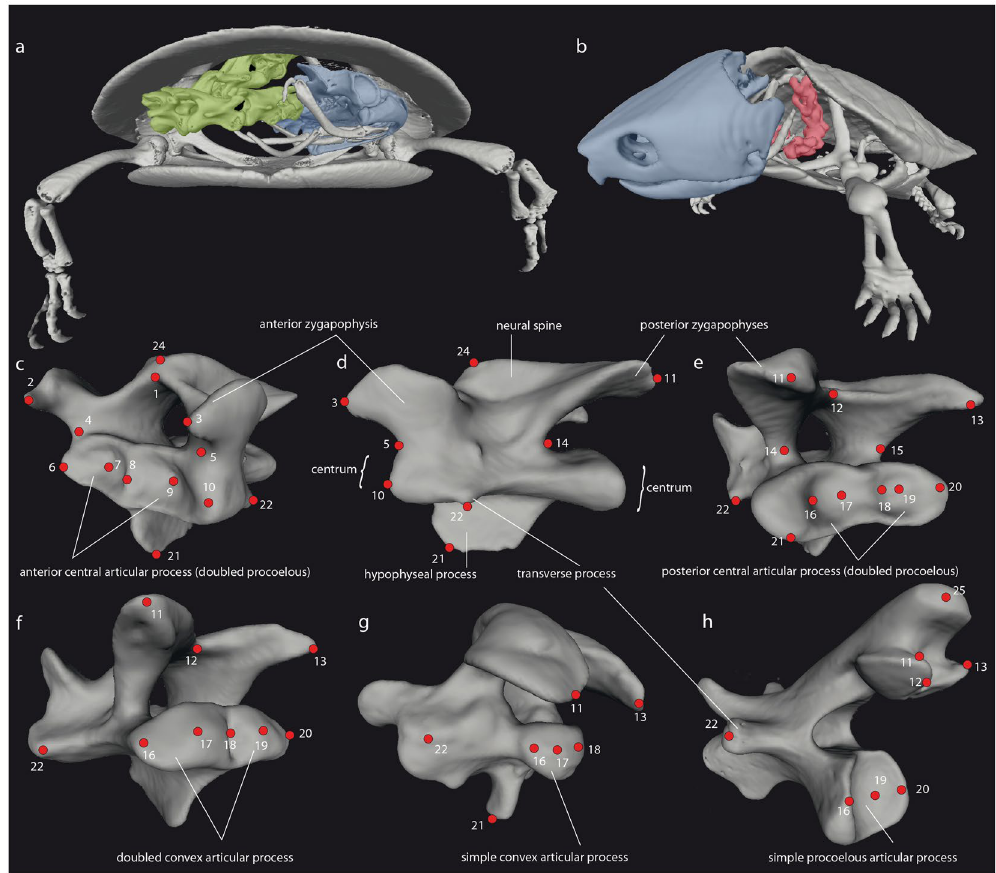
Figure 2. Vertebral morphology of turtles visualized using computer tomography. (a ) Skeleton of the pleurodire turtle Phrynops hilarii in frontal view; the neck (green) is retracted. The skull (blue) fits below the anterior edge of the carapace. ( b ) The skeleton of the cryptodire turtle Platysternon megacephalum in frontolateral view. The neck (orange) is partly retracted. The skull (blue) is too large in this species to be fully retracted under the carapace. Cervical vertebra 7 of P. megacephalum is shown in frontolateral ( c ), left lateral ( d ), and posterolateral ( e ) view. This vertebra has double procoelous central articular processes. Vertebra 6 of this species has a doubled convex ( f ) and cervical 8 has a simple convex articular process ( g ) note the typical cryptodiran anatomy of the posterior zygapophyses in this last cervical vertebra). A simple procoelous articular process is shown for vertebra 7 of Phrynops geoffroanus ( h ). Numbers and red circles refer to the landmarks used in this study (Supplementary Table S2). For details on data sources see Werneburg et al . (2015a,